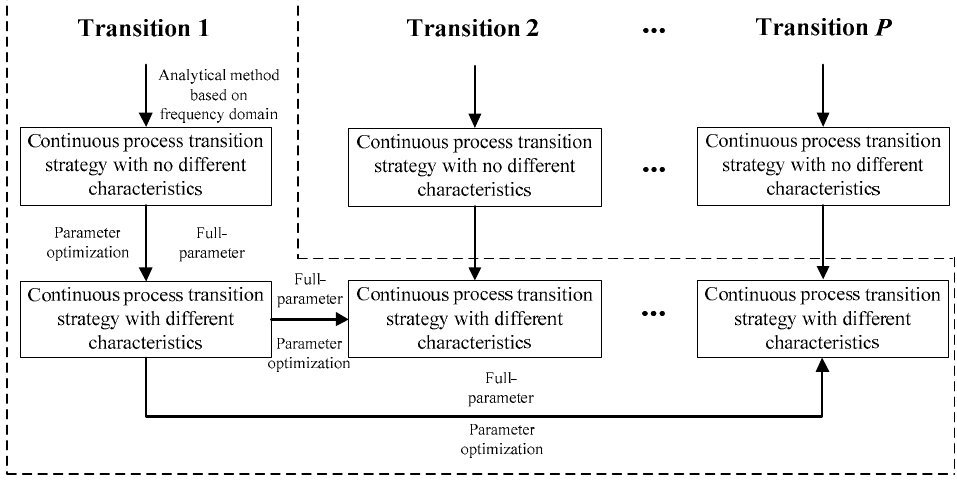
Figure 5. Solution methods of the continuous process transition strategy with different characteristics for different transition processes.